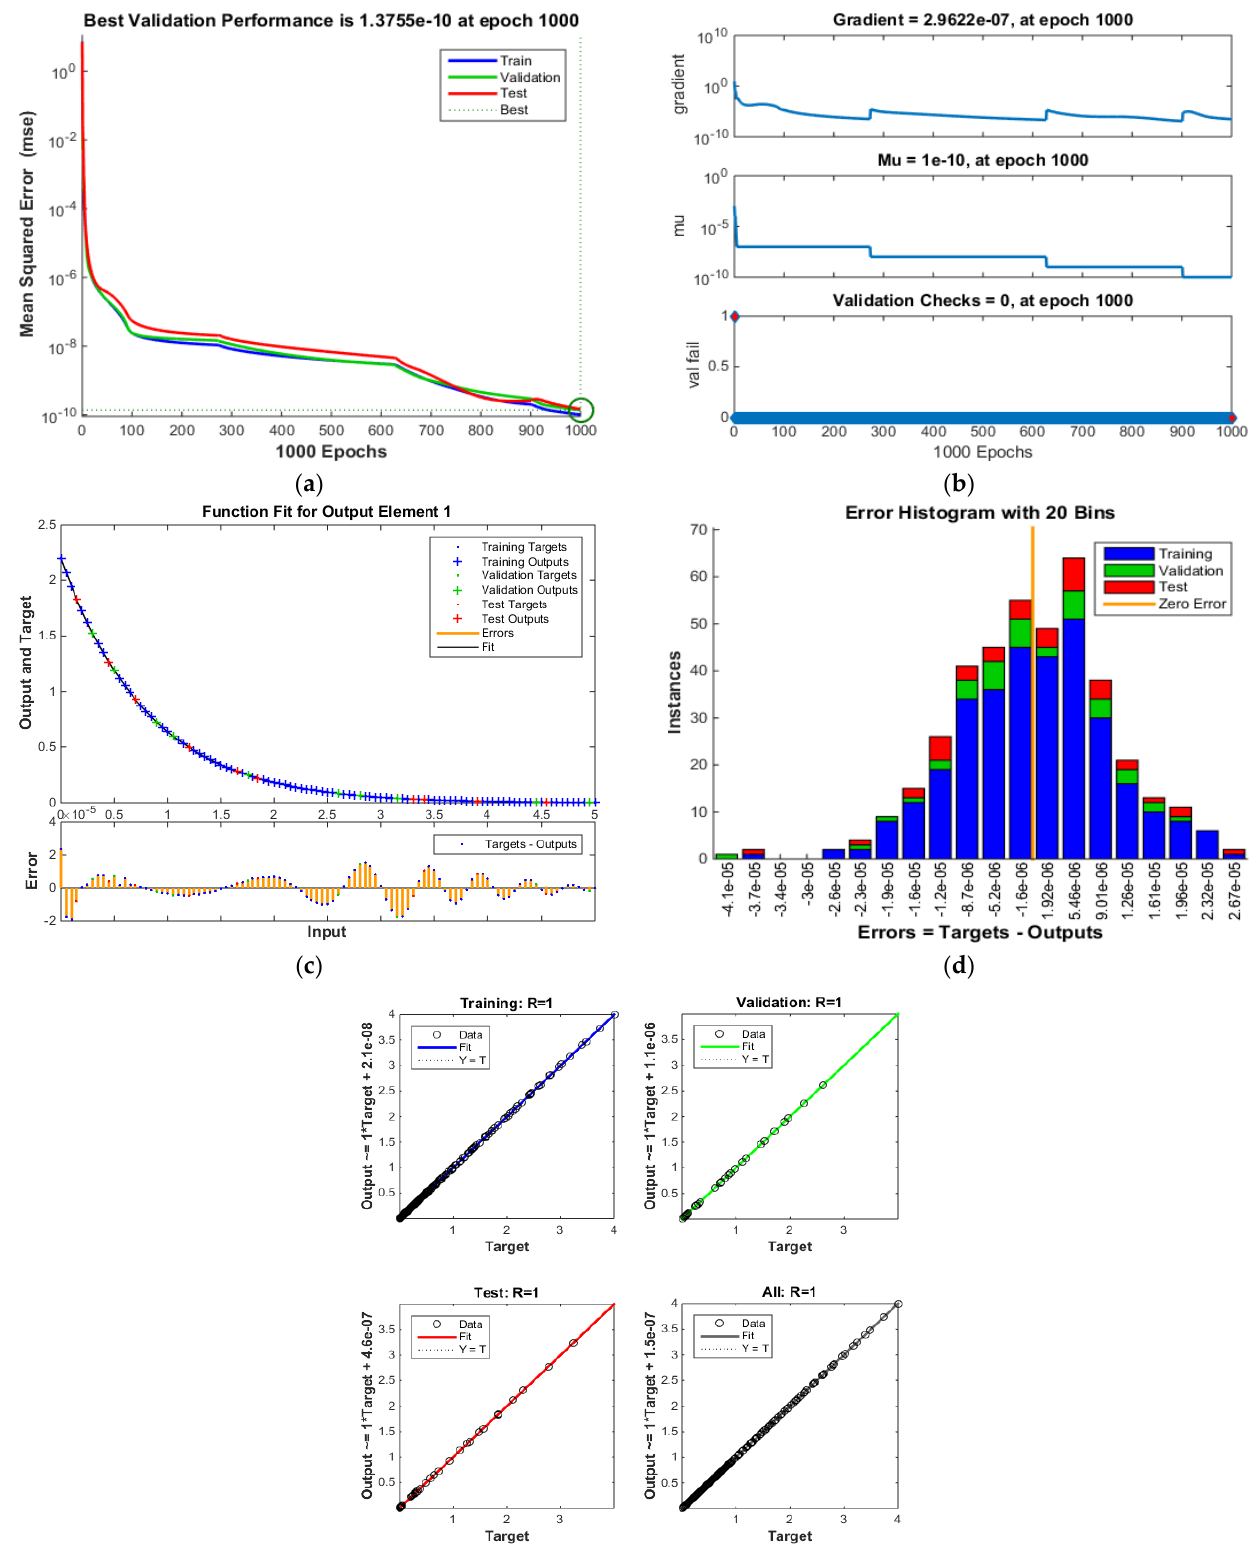
Figure 6. Graphic representation for designed LMT-ABPNN for solving cases of 𝑀𝑎 for 𝑓′(𝜂) of MHD-SGFM. ( a ) MSE Result, ( b ) Results of the transition state, ( c ) Fitness of the curve, ( d ) Histogram for error analysis, ( e ) Regression.